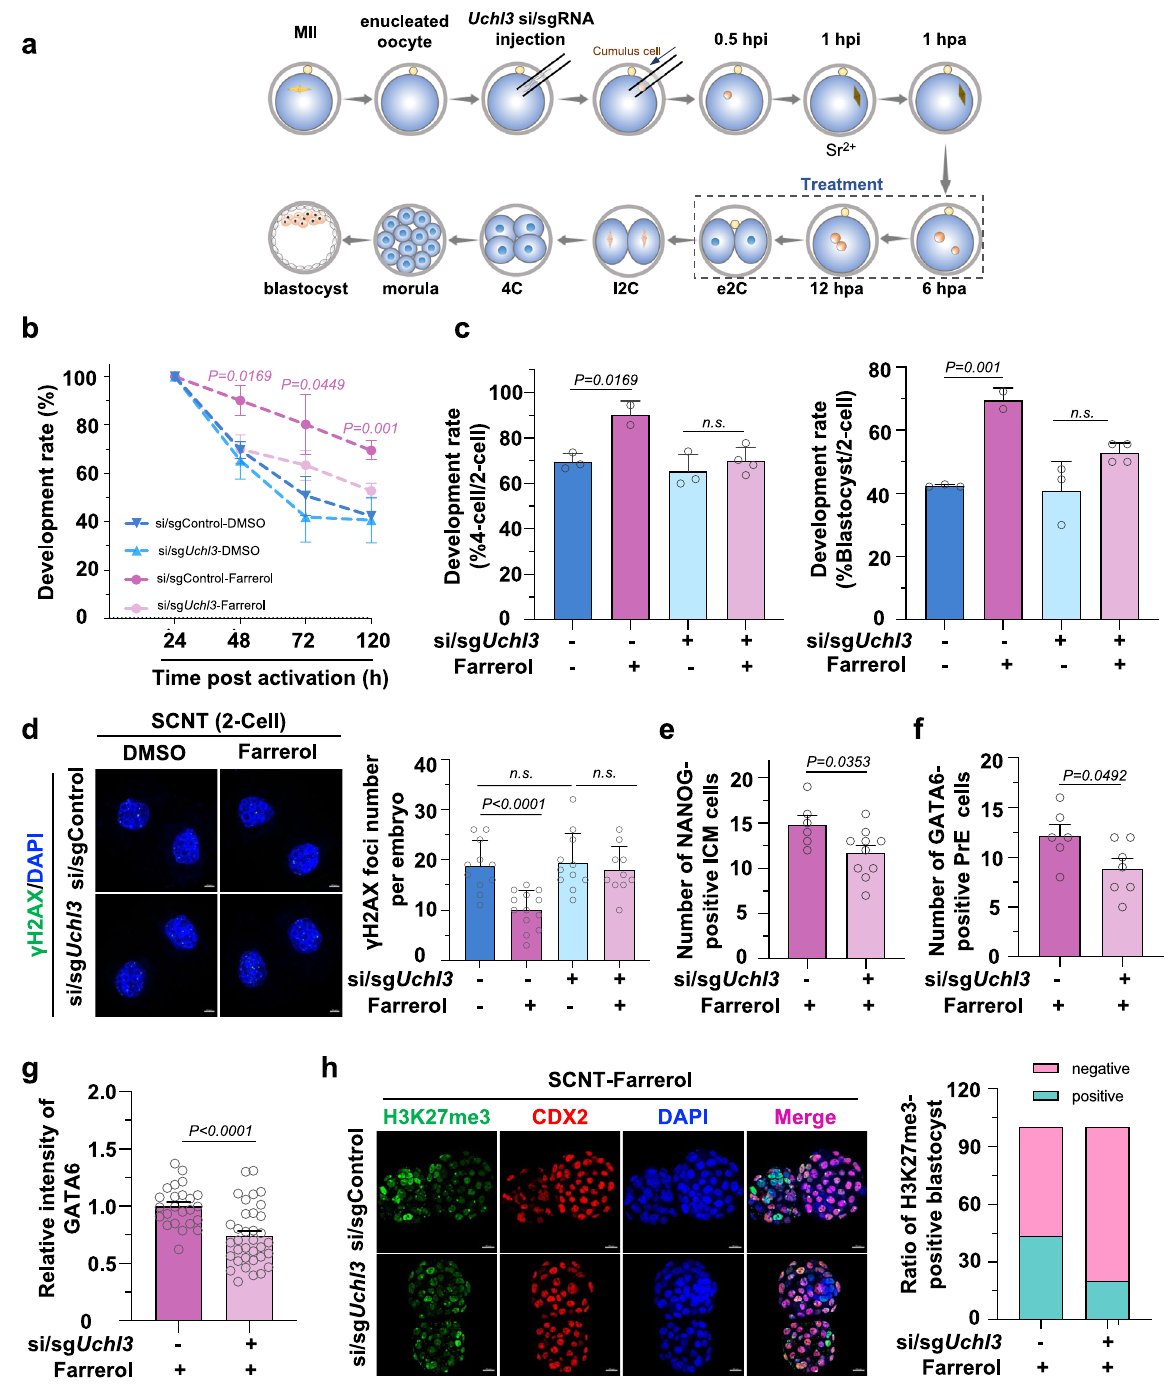
Fig. 6 | Farrerol improved SCNT ef fi ciency through UCHL3. a Illustration of the experimentaldesignfortheinjectionof Uchl3 siRNAsandsgRNAsinSCNTembryos following farrerol treatment. e2C: early two-cell stage, l2C: late two-cell stage, hpi: hours post injection, hpa: hours post activation. b Development rate of SCNT embryos treated with DMSO or farrerol following Uchl3 depletion ( n =2 – 4 embryos). c Development rate of four-cell embryos (left) and hatching blastocysts atE4.5(right)inindicatedgroupsrelatedto( b )( n =2 – 4embryos). d Representative images (left) and quanti fi cation (right) of γ H2AX foci in Uchl3 -depleted two-cell embryoswithorwithoutfarreroltreatment( n =10 – 13embryos).Scalebars,10 μ m. e Plot showing the number of Nanog-positive ICM cells after farrerol treatment following Uchl3 depletion ( n =6 – 10 cells). f Plot showing the number of GATA6-